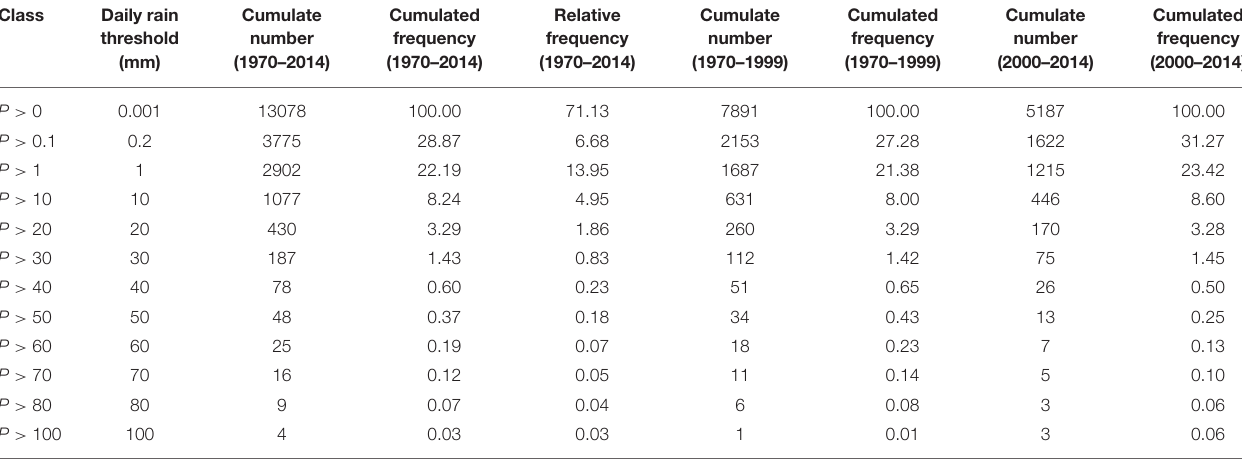
TABLE 1 | Distribution of daily measurements for different daily rainfall